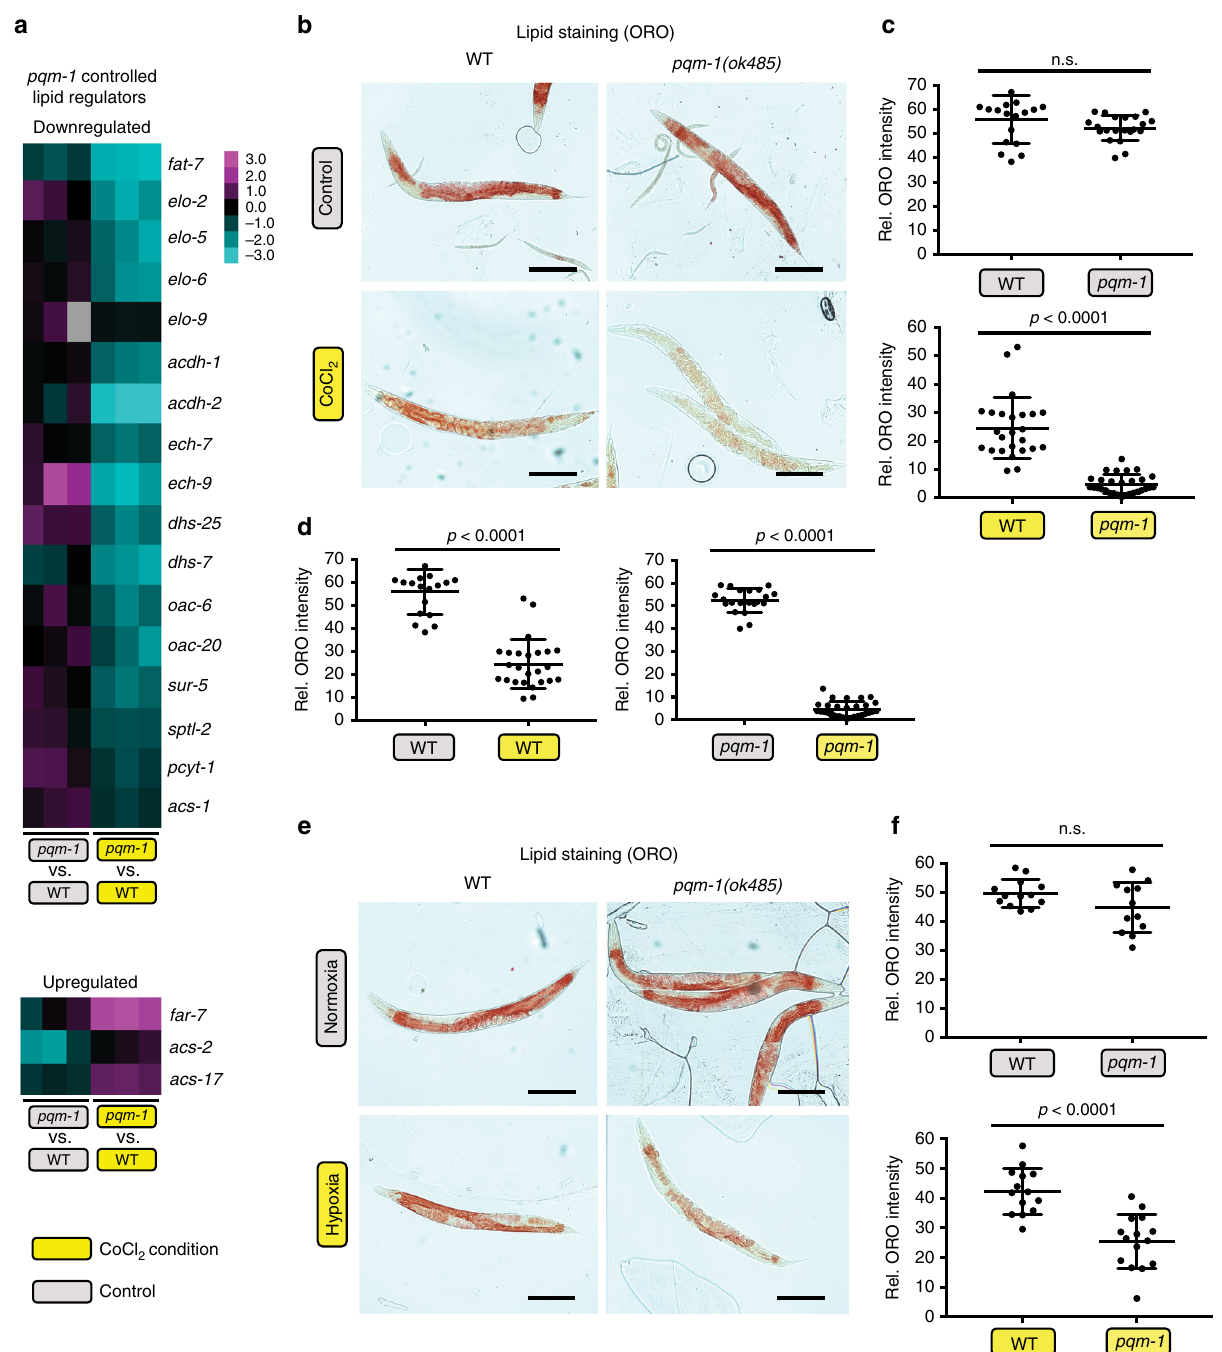
Fig. 3 PQM-1 controls expression of lipid regulators and positively regulates hypoxic fat levels. a Expression based analysis of pqm-1 -dependent regulators implicated in hypoxic lipid metabolism. Two-class SAM ( pqm-1(ok485) + CoCl 2 versus WT + CoCl 2 compared to pqm-1(ok485) − CoCl 2 versus WT − CoCl 2 ) identi fi ed downregulated (top) and upregulated (bottom) lipid regulators. b – f Oil Red O-based lipid staining of animals subjected to control conditions, chemical hypoxia (2.5 mM CoCl 2 , b – d ), and real hypoxia (0.4% oxygen, e , f ) at the early day-1 of adulthood stage for 44 h followed by Oil Red O-based lipid staining ( b , e ) and whole worm quanti fi cation of fat levels ( c , d , f ). Animals were synchronized at the L4 larval stage for adult analyses. Two- tailed t -test, mean ± SD, c , d ) WT (N2) ( n = 18) and pqm-1(ok485) ( n = 21) in control condition; WT (N2) ( n = 25) and pqm-1(ok485) ( n = 29) in CoCl 2 condition. f WT (N2) ( n = 13) and pqm-1(ok485) ( n = 12) in control condition; WT (N2) ( n = 14) and pqm-1(ok485) ( n = 15) in hypoxic condition; ns = not signi fi cant; scale bars: 200 µ m ( b , e ). Four ( b – d ) and two ( e , f ) independent experiments were